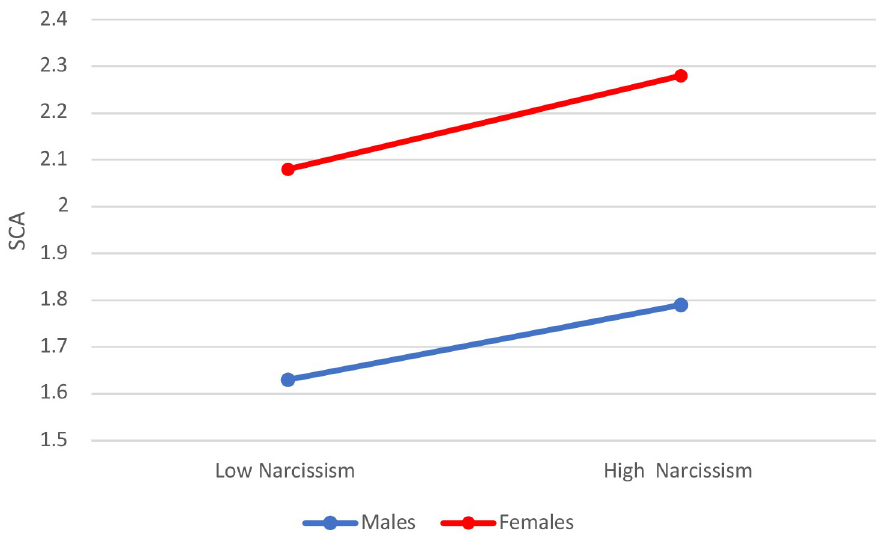
Fig 7. Self-centered appearance focused use of social media (SCA) across low/high narcissism males and females. https://doi.org/10.1371/journal.pone.0272868.g007 Finally, mediation analysis was performed to assess the mediating role of the self-centered appearance focused use of social media (SCA) between social media use (SNS use) and narcis- sism (Bootstrap = 1000 in both indexes). For NPQC-R, both the total effect ( β = .0468, z = 2.5, p = .013) and the indirect effect ( β = .0179, z = 2.22, p = .027) were significant, but the direct effect was not ( β = .0289, z = 1.45, p = .148). For NPI-13, mediation of NCA was confirmed, results revealed a positive total effect ( β = .458, z = 7.92, p < .001), indirect effect ( β = .191, z = 6.82, p < .001) and direct effect accounting SCA ( β = .267, z = 4.47, p < .001). Indirect effect of SCA explained 41.6% of the mediation for NPI-13 and 38.2% of the moderation for NPQC-R (see Fig 9). Table 9. Self-centered appearance focused use of social media (SCA) by countries, gender, and low/high narcissism.